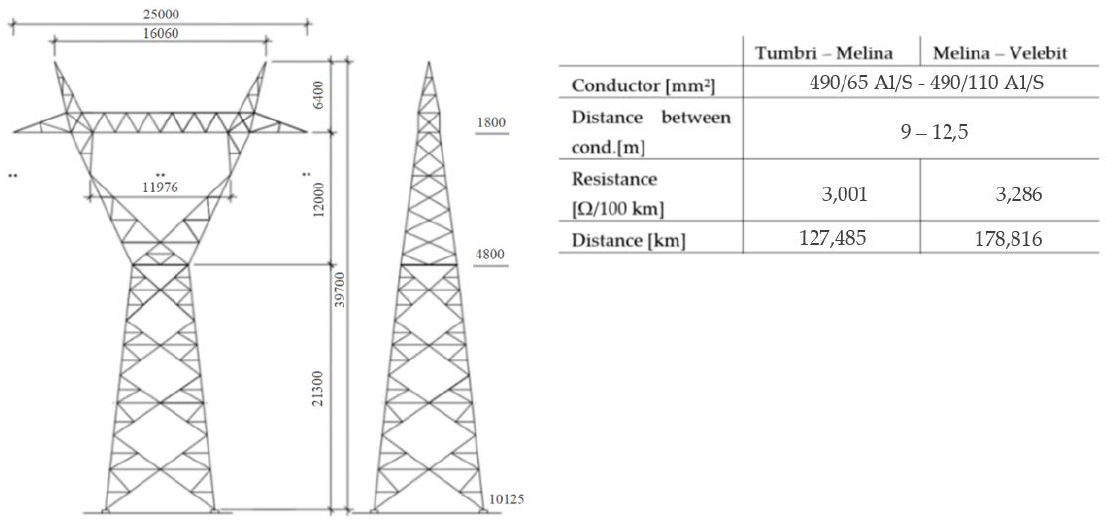
Figure 11. Main technical characteristics of 400 kV lines.